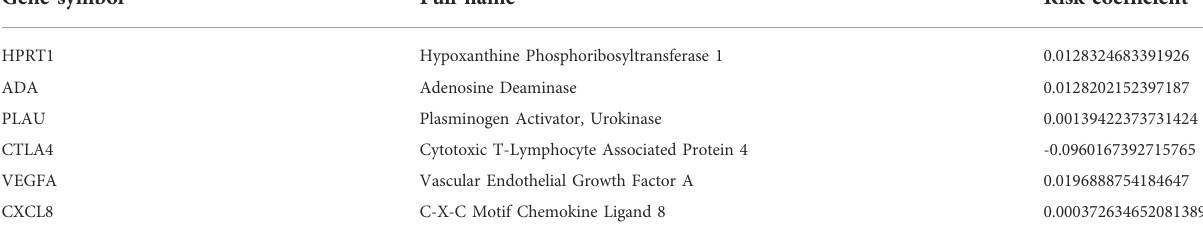
TABLE 1 The prognostic model genes and their risk coef fi